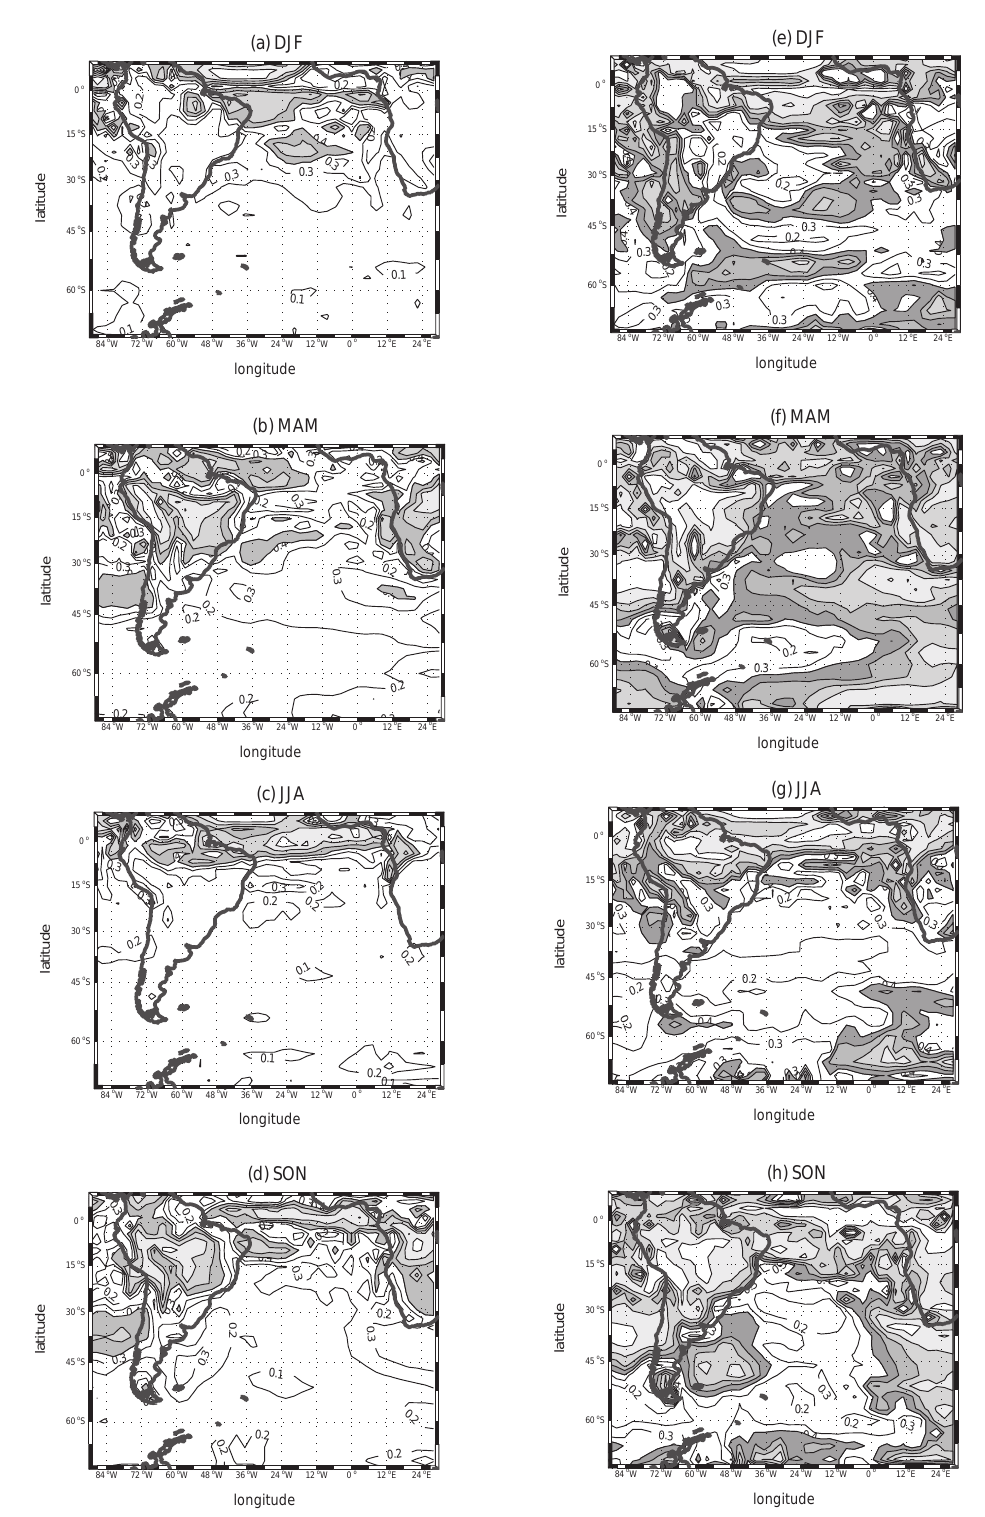
Fig. 3. Spatial distribution of reproducibility for the original ( a–d , left column) and reconstructed ensemble ( e–h , right column) in the South Atlantic region. Shaded areas indicate reproducibility greater than 0.4. Contour interval is 0.1. Adapted from Taschetto and Wainer